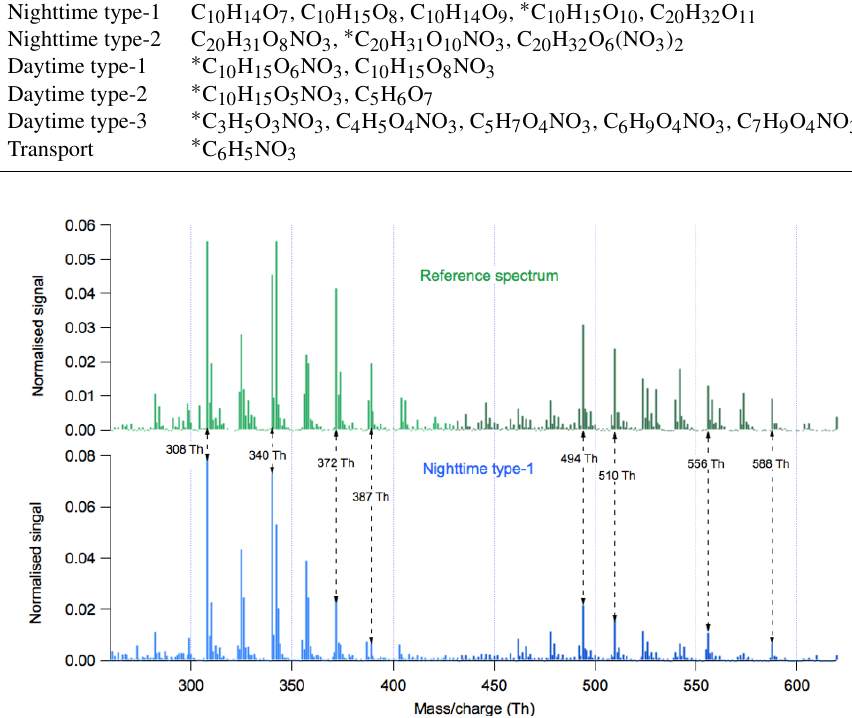
Table 1. Suggested elemental composition of fingerprint molecules of the six factors. ∗ Peak fitting are shown in Fig. S10. Factor